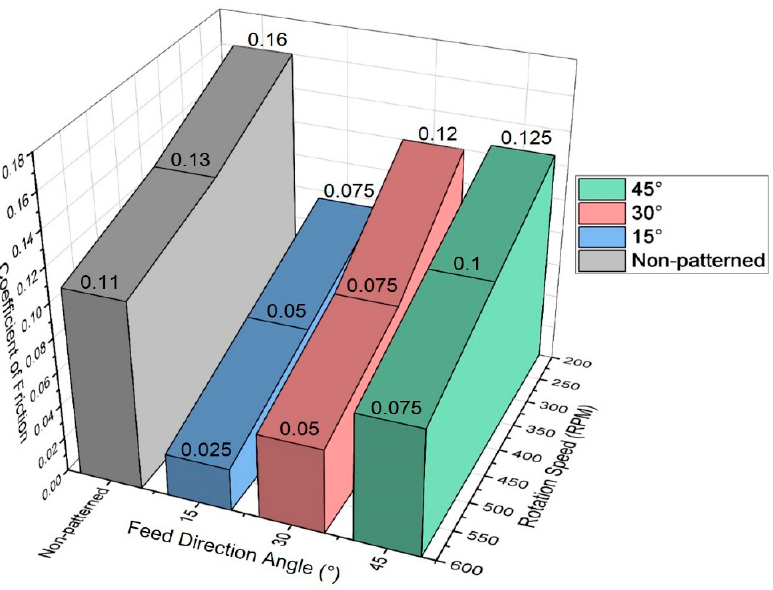
Figure 10. The relationship between the rotating velocity and friction coefficient for the sample.